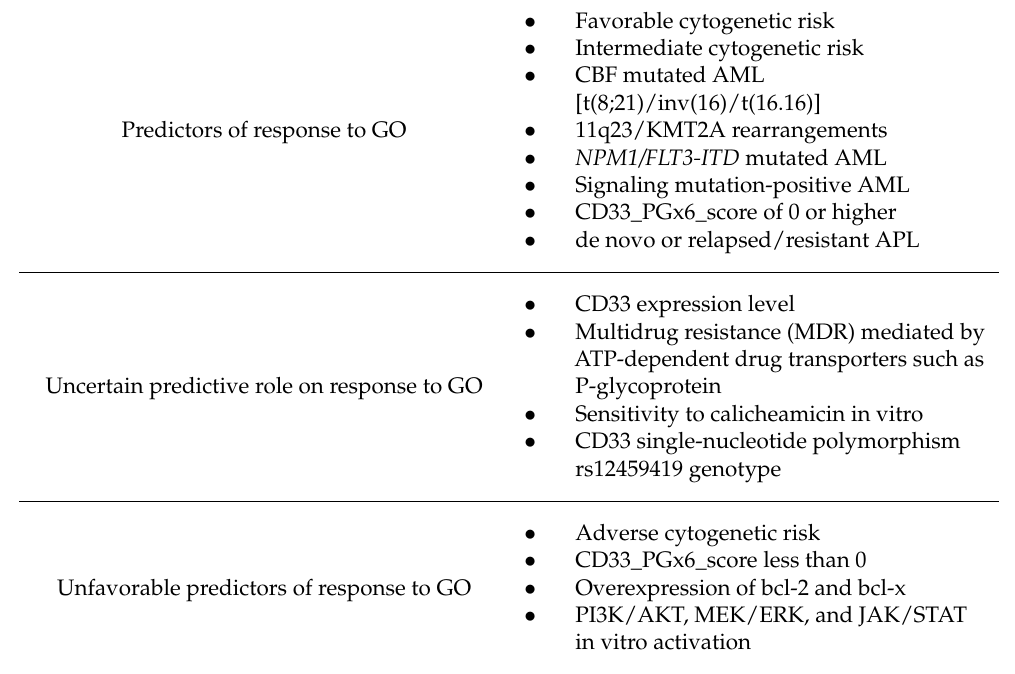
Table 2. Predictors of response to